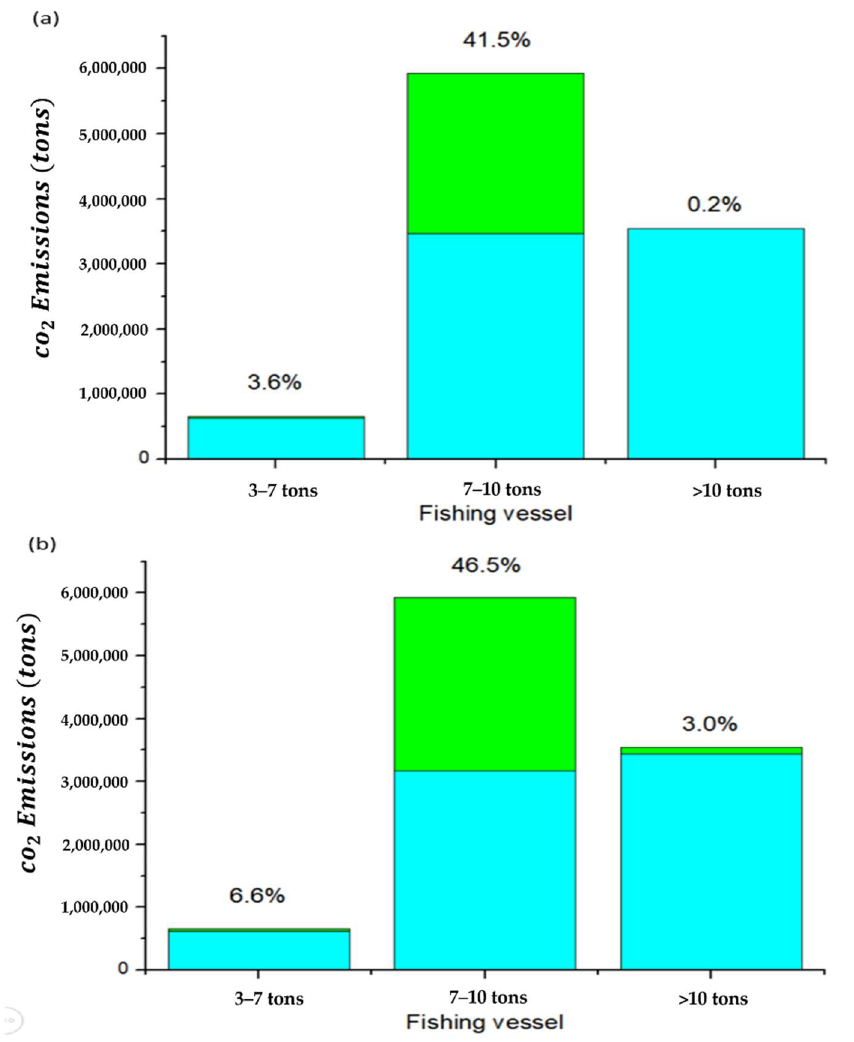
Figure 10. Annual carbon dioxide emissions reduction, by tonnage, of fishing boats in Korea: ( a ) battery hybrid electric propulsion system; ( b ) battery hybrid electric propulsion system with ECMS control.